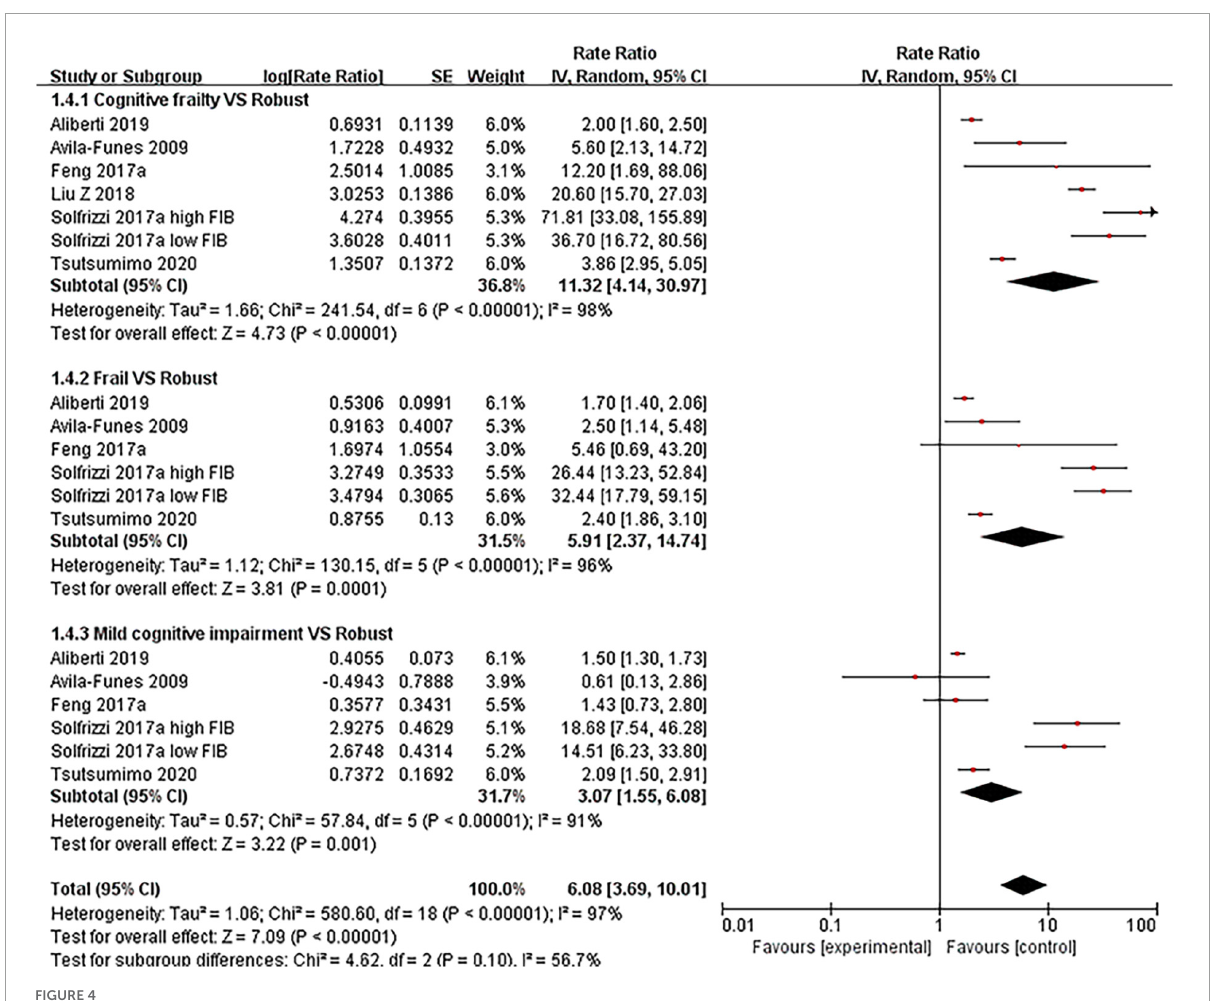
FIGURE4 Forest plot of the association between cognitive frailty, frailty, and mild cognitive impairment and disability in older adults (reference group: participants were free of frailty and mild cognitive impairment), using random-effects meta-analysis. 95% CI, 95% confidence interval; high FIB, high fibrinogen (inflammatory); low FIB, low fibrinogen